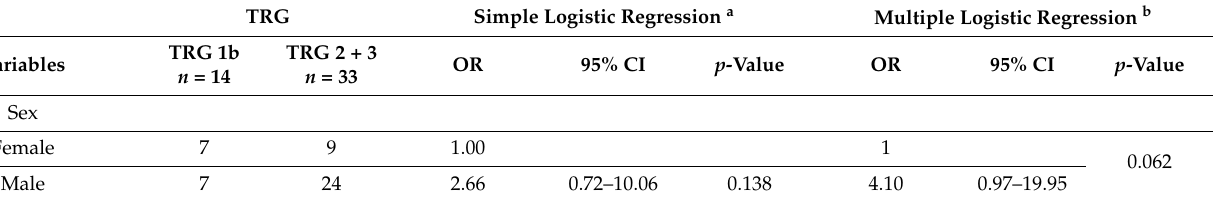
Table 3. Univariate andmultivariate analysis of tumor regression status after neoadjuvant chemother- apy. TRG Simple Logistic Regression a Multiple Logistic Regression